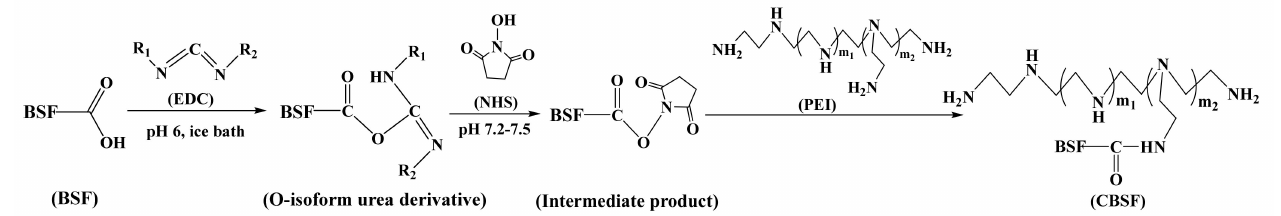
Figure 1. Schematic diagram of CBSF synthesis.